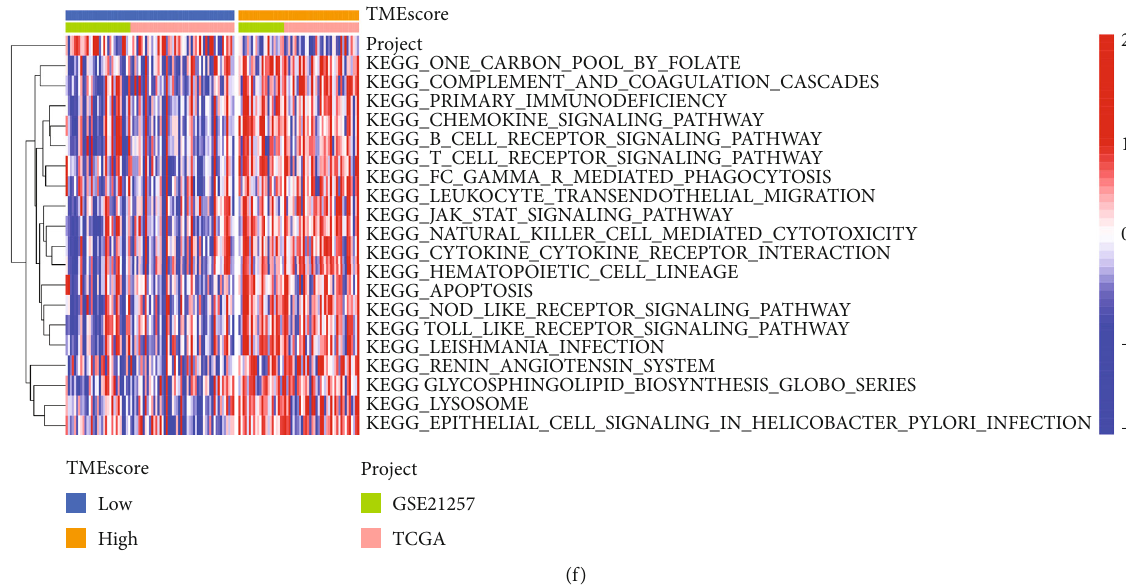
Figure 5: Construction and validation of TMEscore for predicting clinical outcome. (a) Heatmap of consensus matrix (consensus matrix K = 2 ). Unsupervised clustering based on 7 genes divided the samples into two categories. (b) Alluvial representation of the relationship between TME subtypes, TMEscore subgroups, and clinical outcomes. (c) KM analysis of high- and low-TMEscore subgroups in TCGA cohort (d) and external validation cohort (GSE21257). (e) KM analysis of high- and low-TMEscore subgroups in all OS cohorts (TCGA and GSE21257). (f) GSVA enrichment analysis showed the activation status of signaling pathways in various TMEscore subgroups. Heatmap visualization of these biological processes. Red indicates activated pathways. Blue indicates suppressed